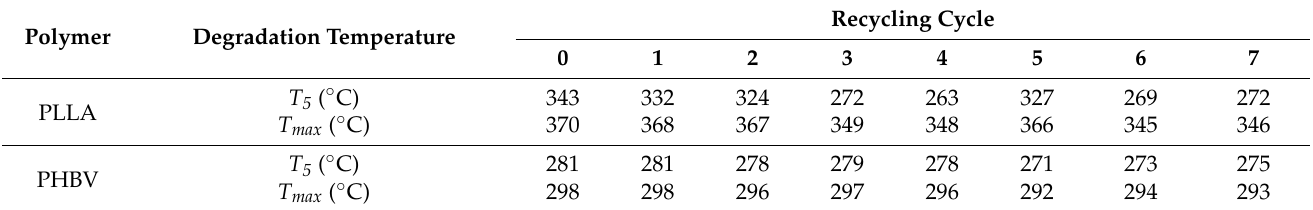
Table 3. Thermogravimetric analysis of PLLA and PHBV as a function on the number of recycling cycles.